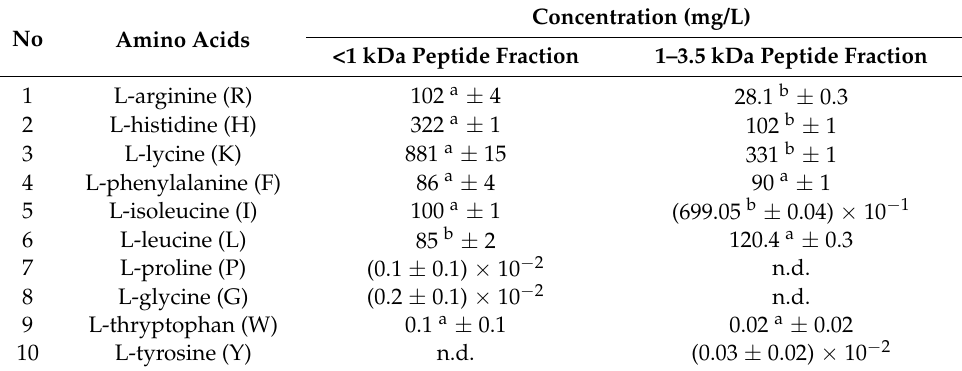
Table 1. Amino acid composition of the peptide